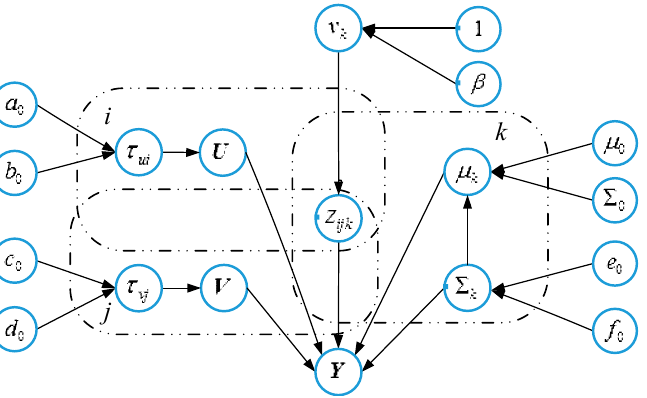
Figure 3. Graphical representation of the variational low-rank matrix decomposition